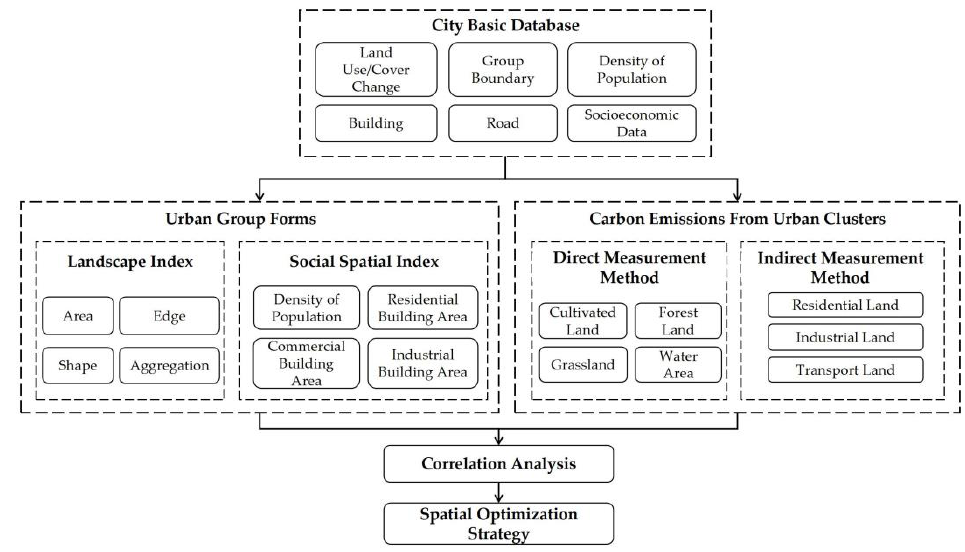
Figure 1. The Framework for Analyzing.